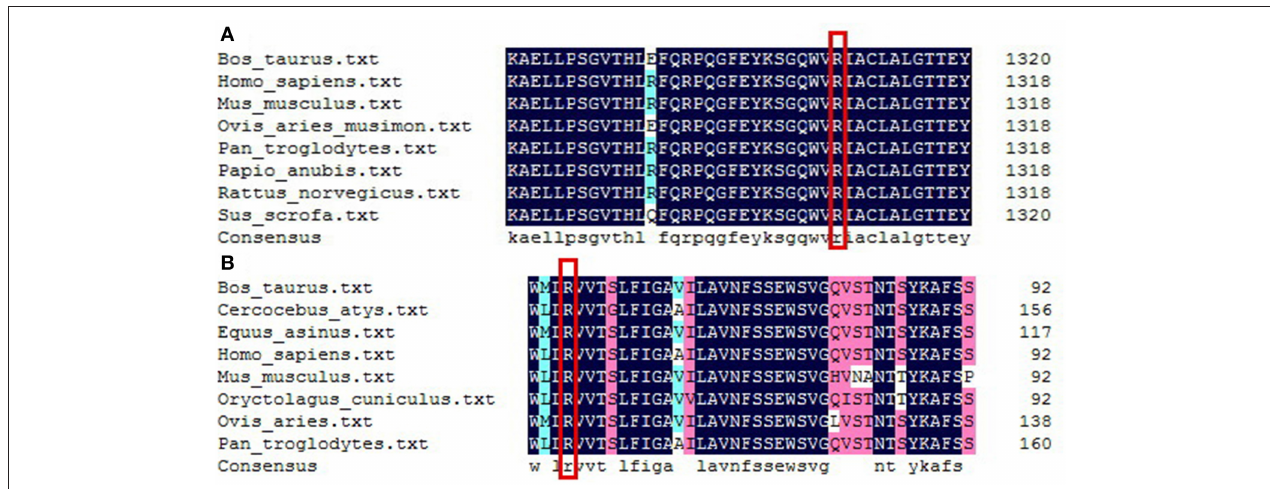
FIGURE 2 | Sequence alignment analysis of DUOX1 (A) and DUOXA1 (B) in different species. (A) Red rectangle indicates arginine at amino acid 1307of DUOX1 located in a conserved sequence of the DUOX1 protein. (B) Red rectangle indicates arginine at amino acid 56 of DUOXA1 located in a conserved sequence of the DUOXA1